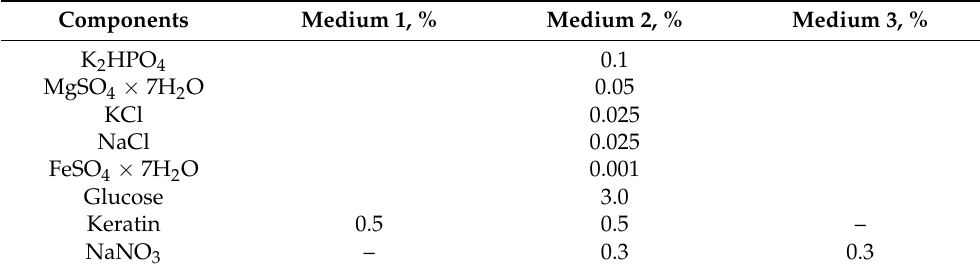
Table 1. Modified Czapek medium composition.